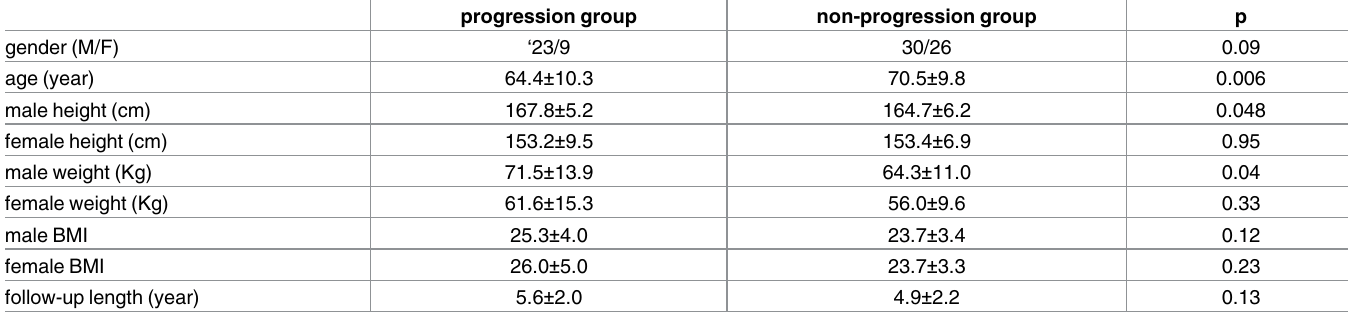
Table 3. Demographic data of the progression group and the non-progression group.